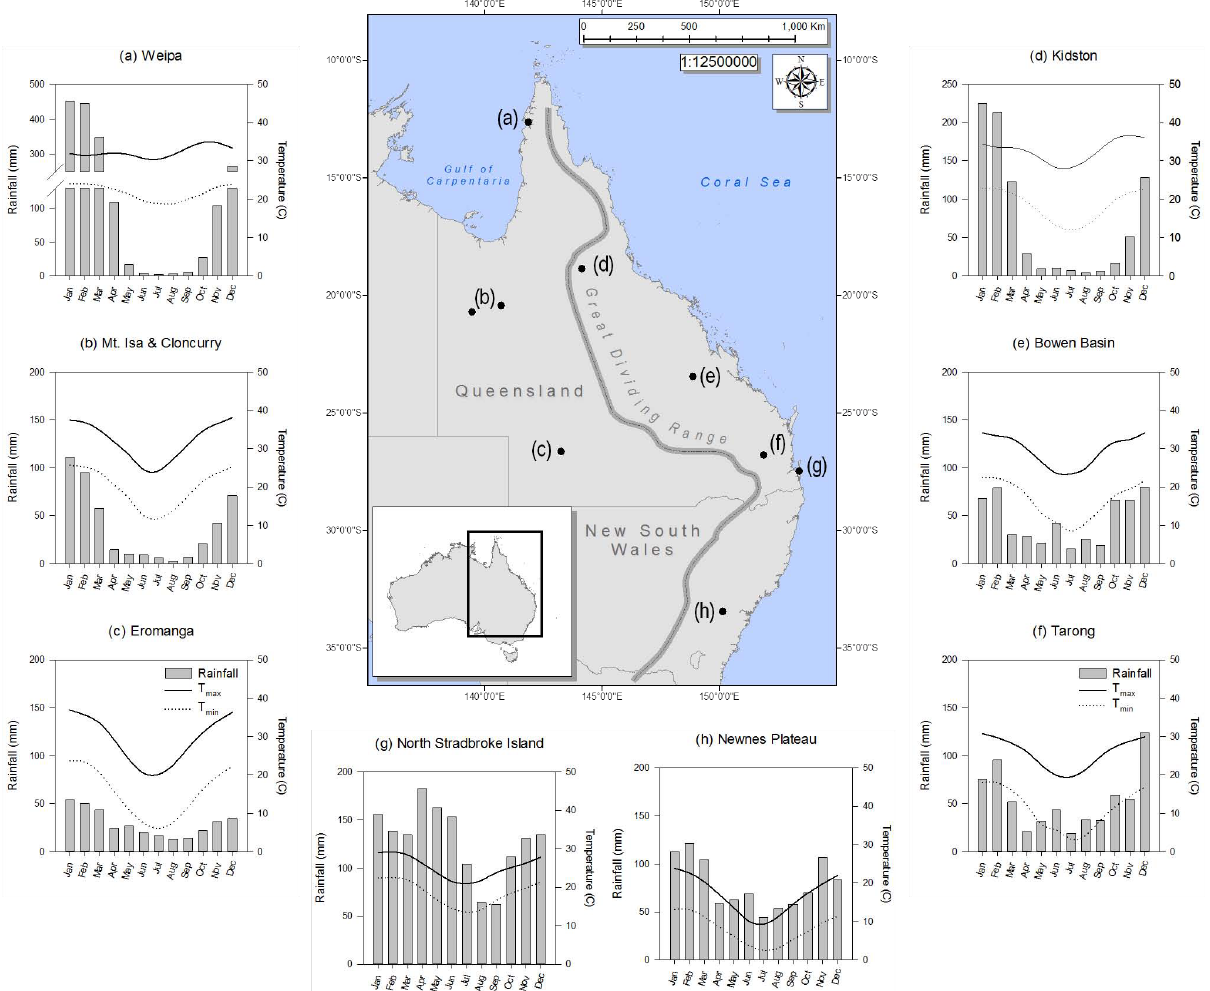
Fig. 1. Climate parameters (average monthly temperature and rainfall) for selected mine sites in eastern